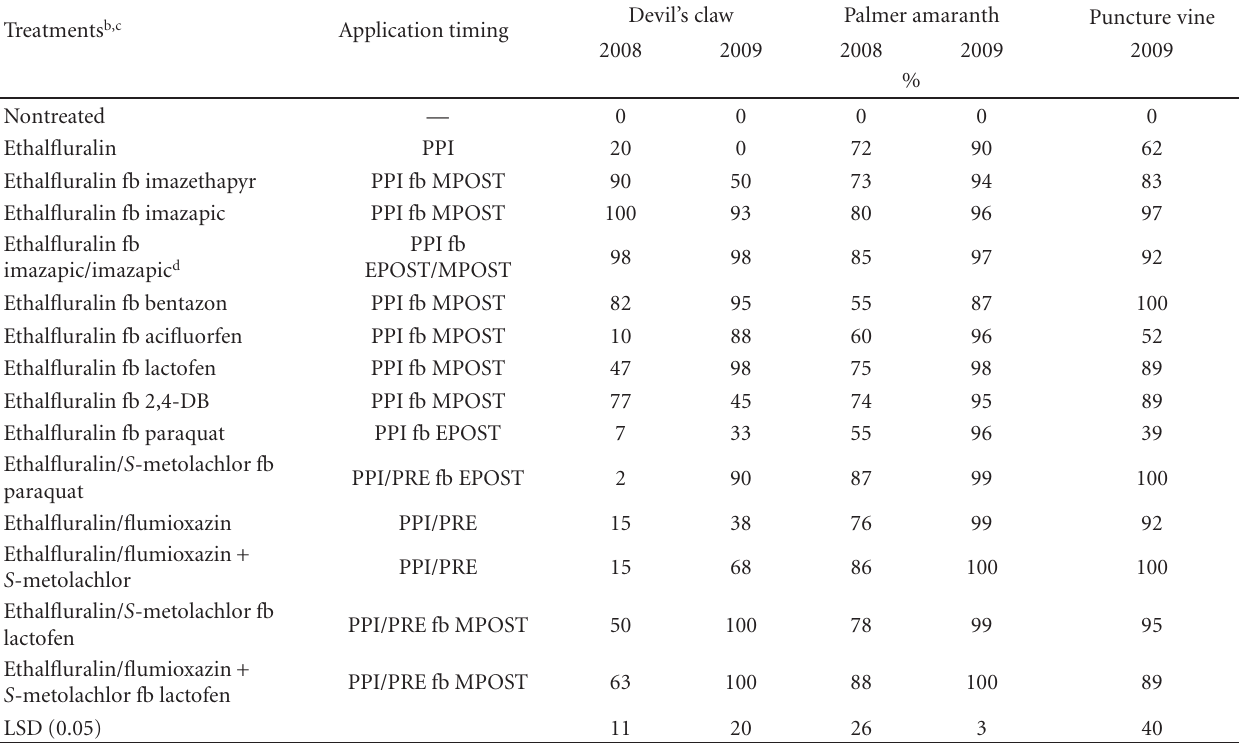
Table 1: Weed control in the Texas High Plains with herbicide systems which include ethalfluralin. a